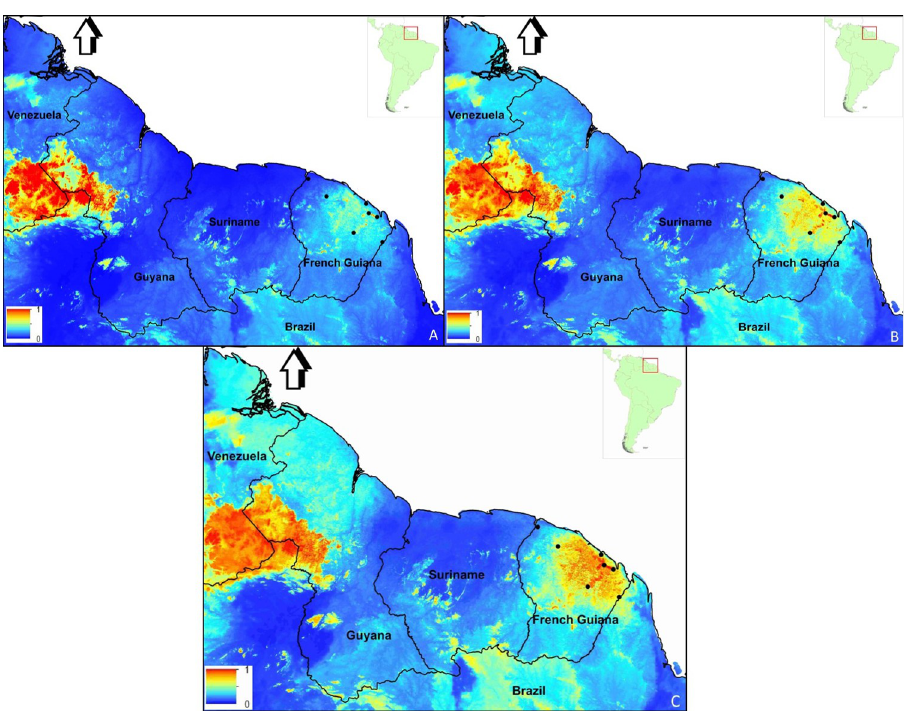
Fig 3. Potential distribution of the chytrid fungus Batrachochytrium dendrobatidis (Bd) in the three Guianas, projected using maxent models of six climate metrics. A) the minimum distribution; B) median distribution; C) the maximum distribution. Warmer colors indicate a higher suitability of the area for Bd infection. Black points are Bd positive sites in French Guiana.